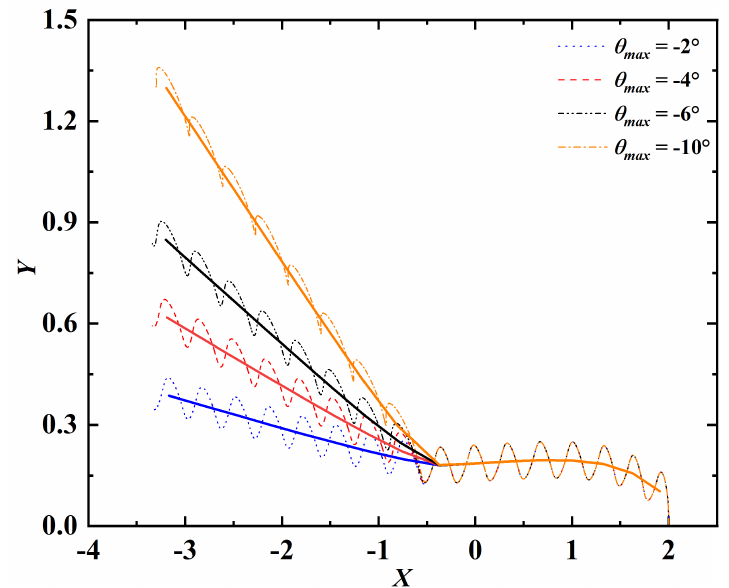
Figure 20. Trajectories of the leading edge for turning maneuvers with different values of θ max . The dashed lines represent the actual trajectories. The solid lines represent the trajectories after periodic averaging.